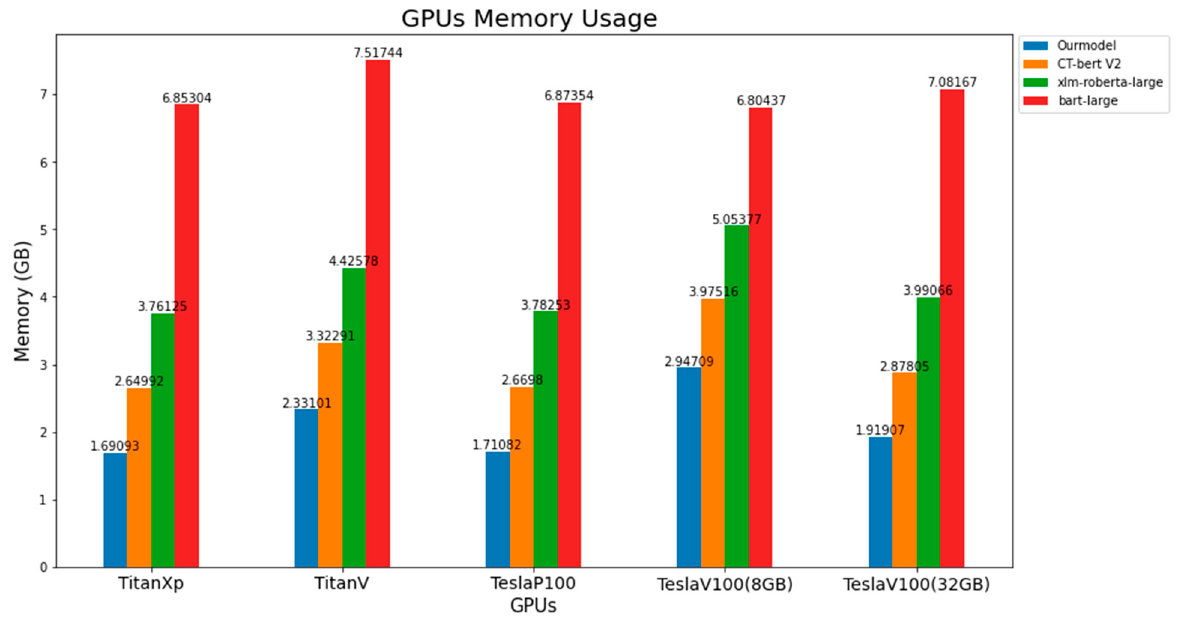
Figure 7. Comparison of GPU memory usage of all models on different GPUs .